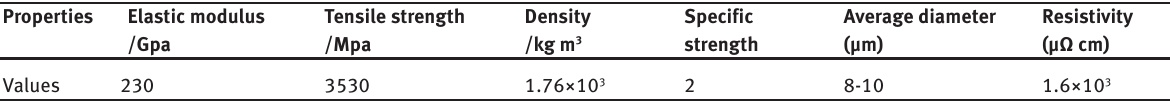
Table 1: The properties of the carbon fiber. Properties